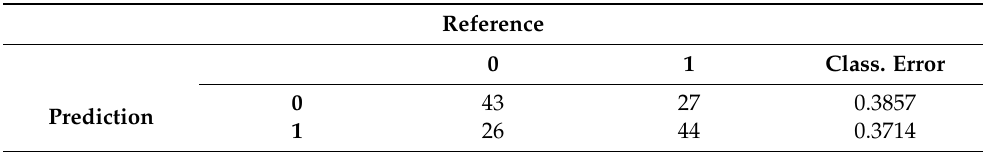
Table 4. Confusion Matrix-32